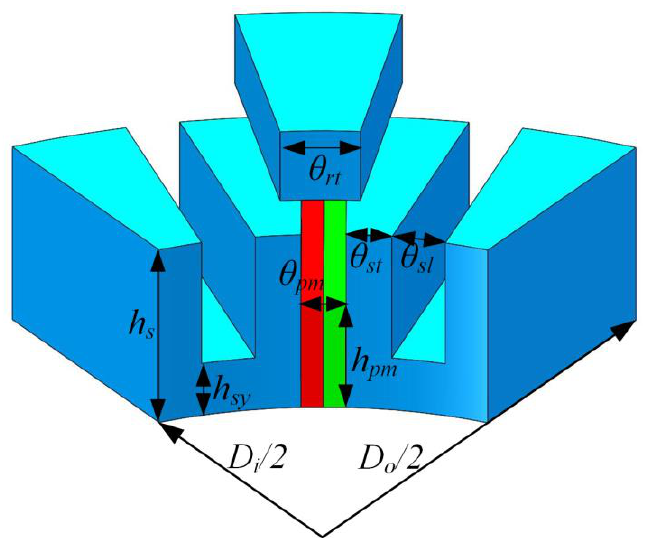
Figure 4. Original design structure of the machine with the rotor at the q-axis position.